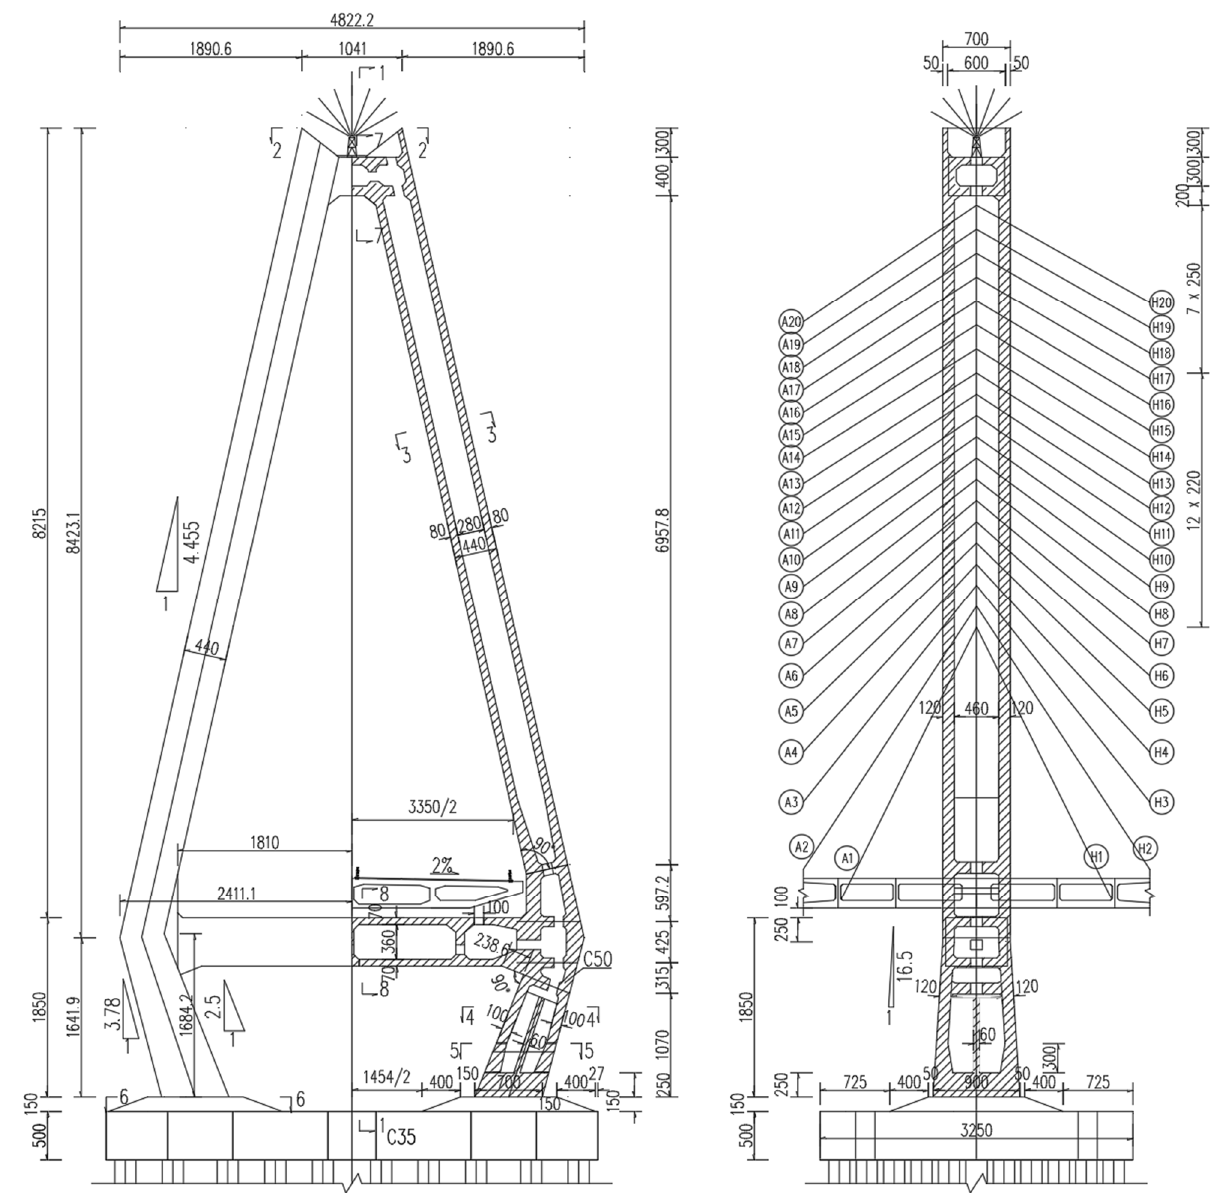
Figure A1. Tower design of bridge prototype (unit: mm).